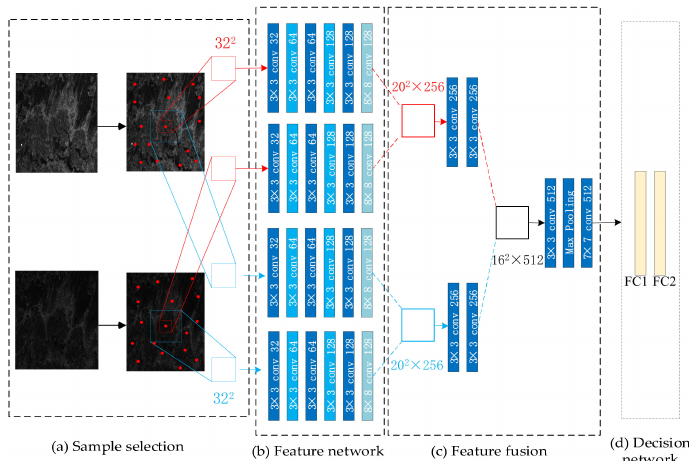
Figure 6. Flowchart of our method for intensity difference sea ice image matching. It includes four parts: ( a ) Sample selection: sample patches are obtained using the control point method. The red and blue boxes represent the intercepted image patch; the size of image patch is 32 × 32. ( b ) Feature network: the image patch is input to the feature network to extract the network features. ( c )